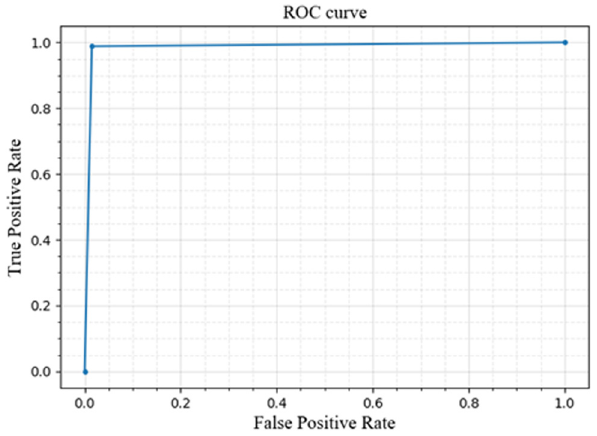
Figure 9: Receiver operating characteristic curve.